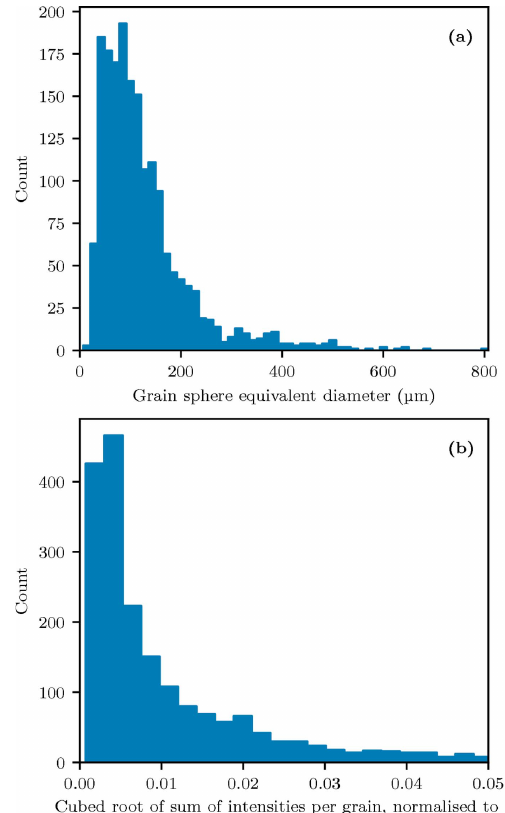
Figure 9 Grain size distribution histogram from ( a ) EBSD and ( b ) distribution of the cubed root of grain peak intensities from